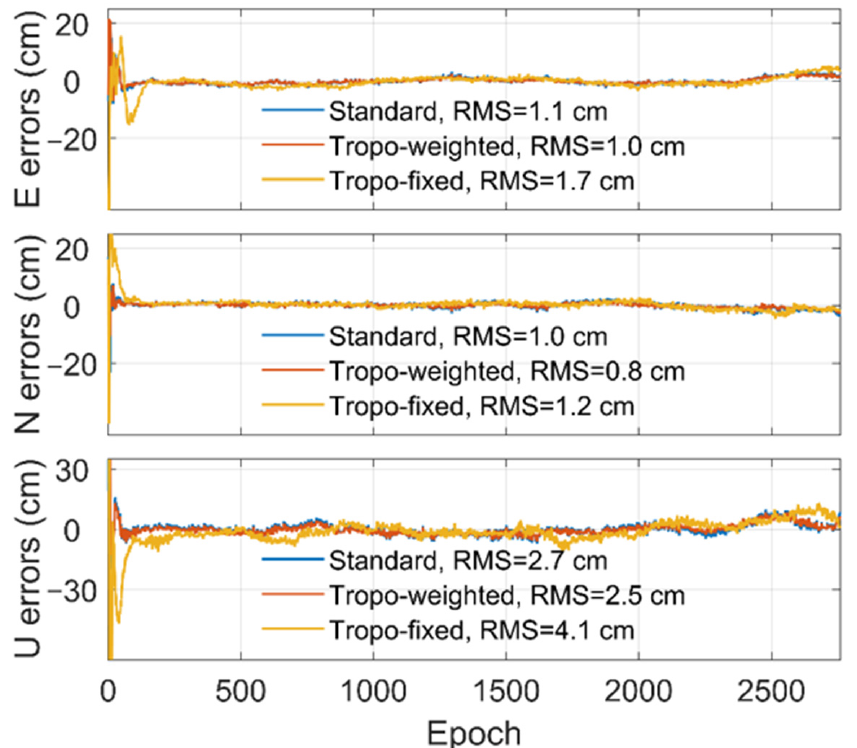
Figure 4. Ambiguity-float solutions of East, North, and Up component of the user station NCWA under the standard, tropospheric-weighted, and tropospheric-fixed model.